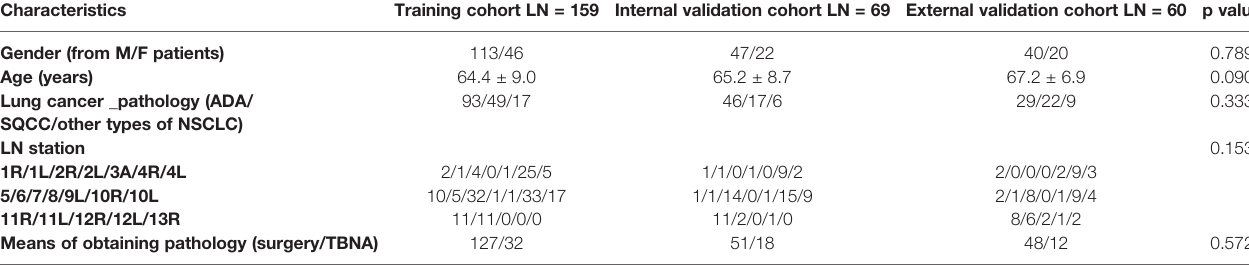
TABLE 1 | Demographics and lymph node distribution of training and two validation cohorts. Characteristics